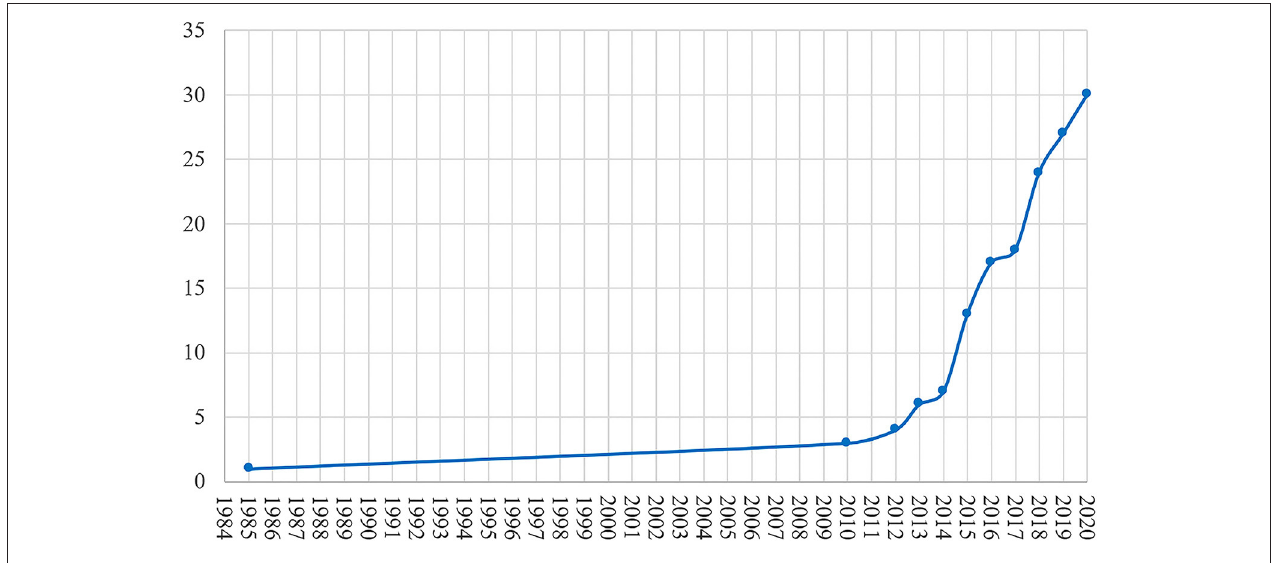
FIGURE 1 | The cumulative growth of studies of DBS in